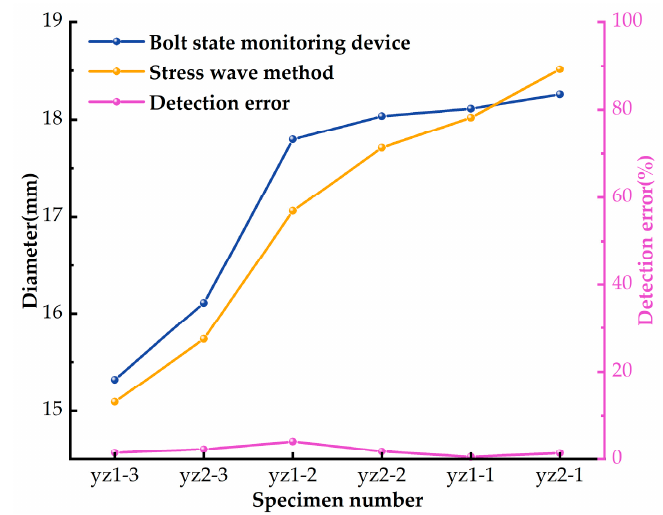
Figure 15. Comparison of test results and error curve.